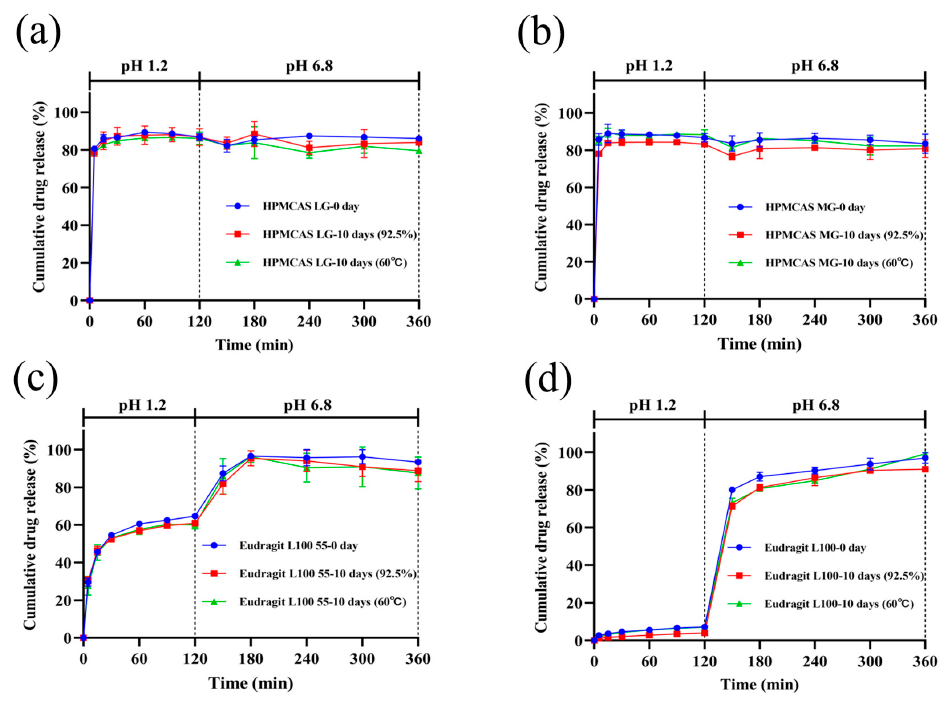
Figure 12. pH shift dissolution behavior of ASDs before and after being subjected to high temperature and high humidity for 10 days (mean ± SD, n = 3). ( a ) HPMCAS LG, ( b ) HPMCAS MG, ( c ) Eudragit L100 55, ( d ) Eudragit